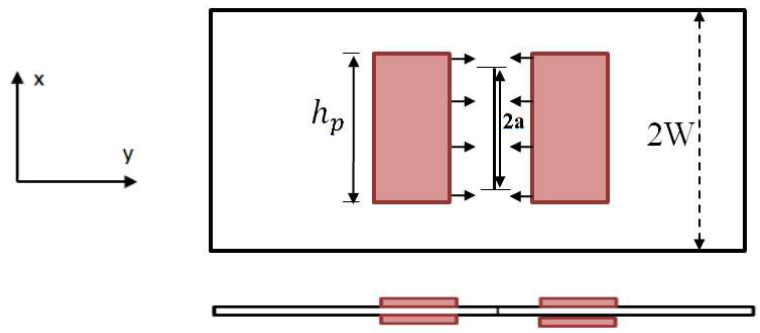
Figure 1. Centre-cracked plate with integrated piezoelectric actuators.